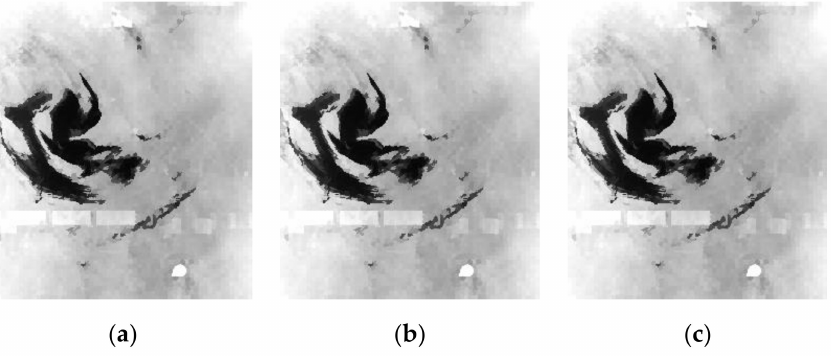
Figure 14. Image stretching results with different thresholds: ( a ) 0.67, ( b ) 0.73, and ( c )